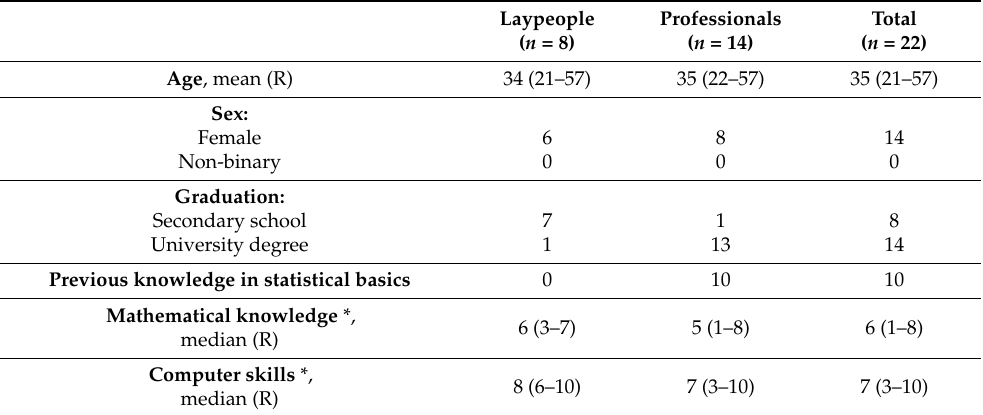
Table 1. Baseline characteristics of